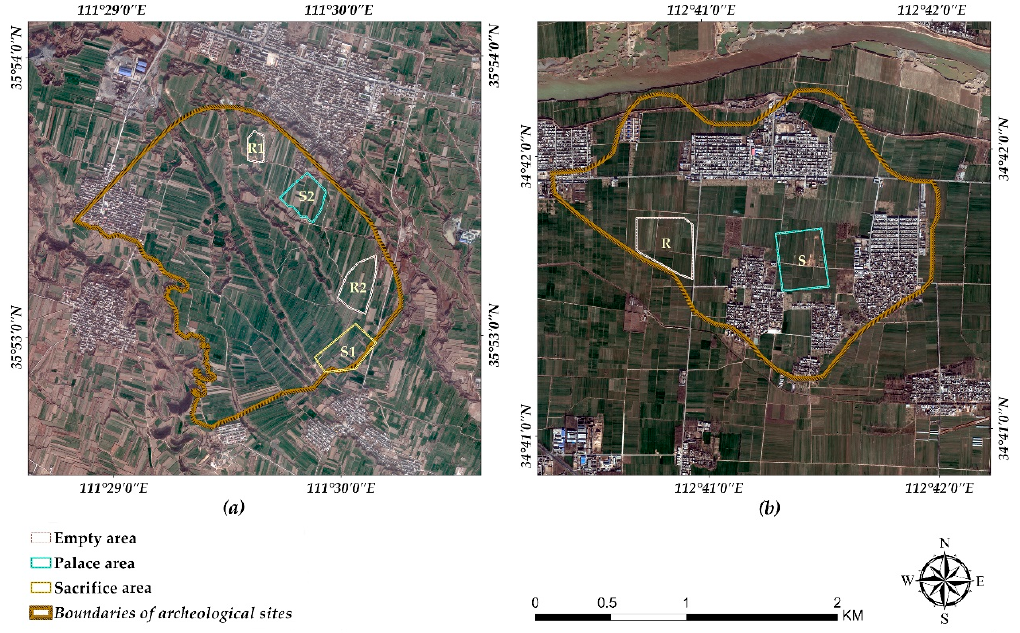
Table 2. The main attribute of samples.